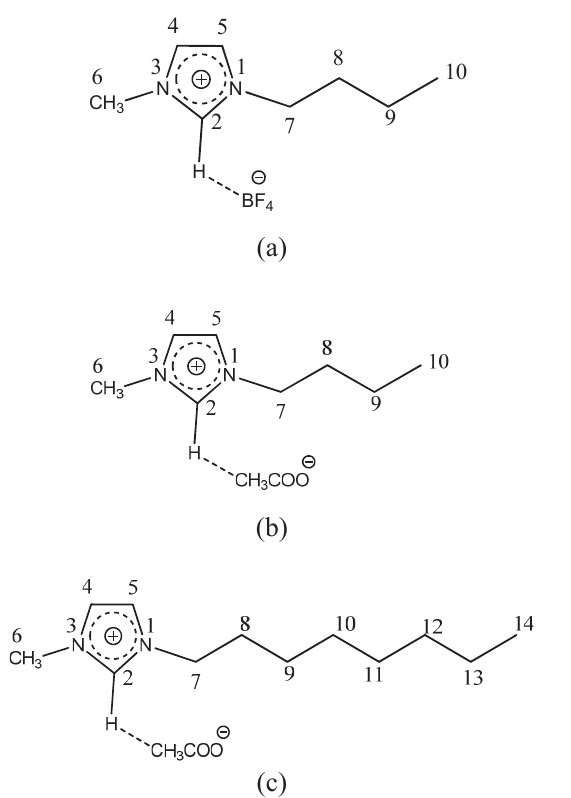
Fig. 2 Structure of synthesized ionic liquids (a: [BMIM][BF 4 ], b: [BMIM][CH 3 COO],